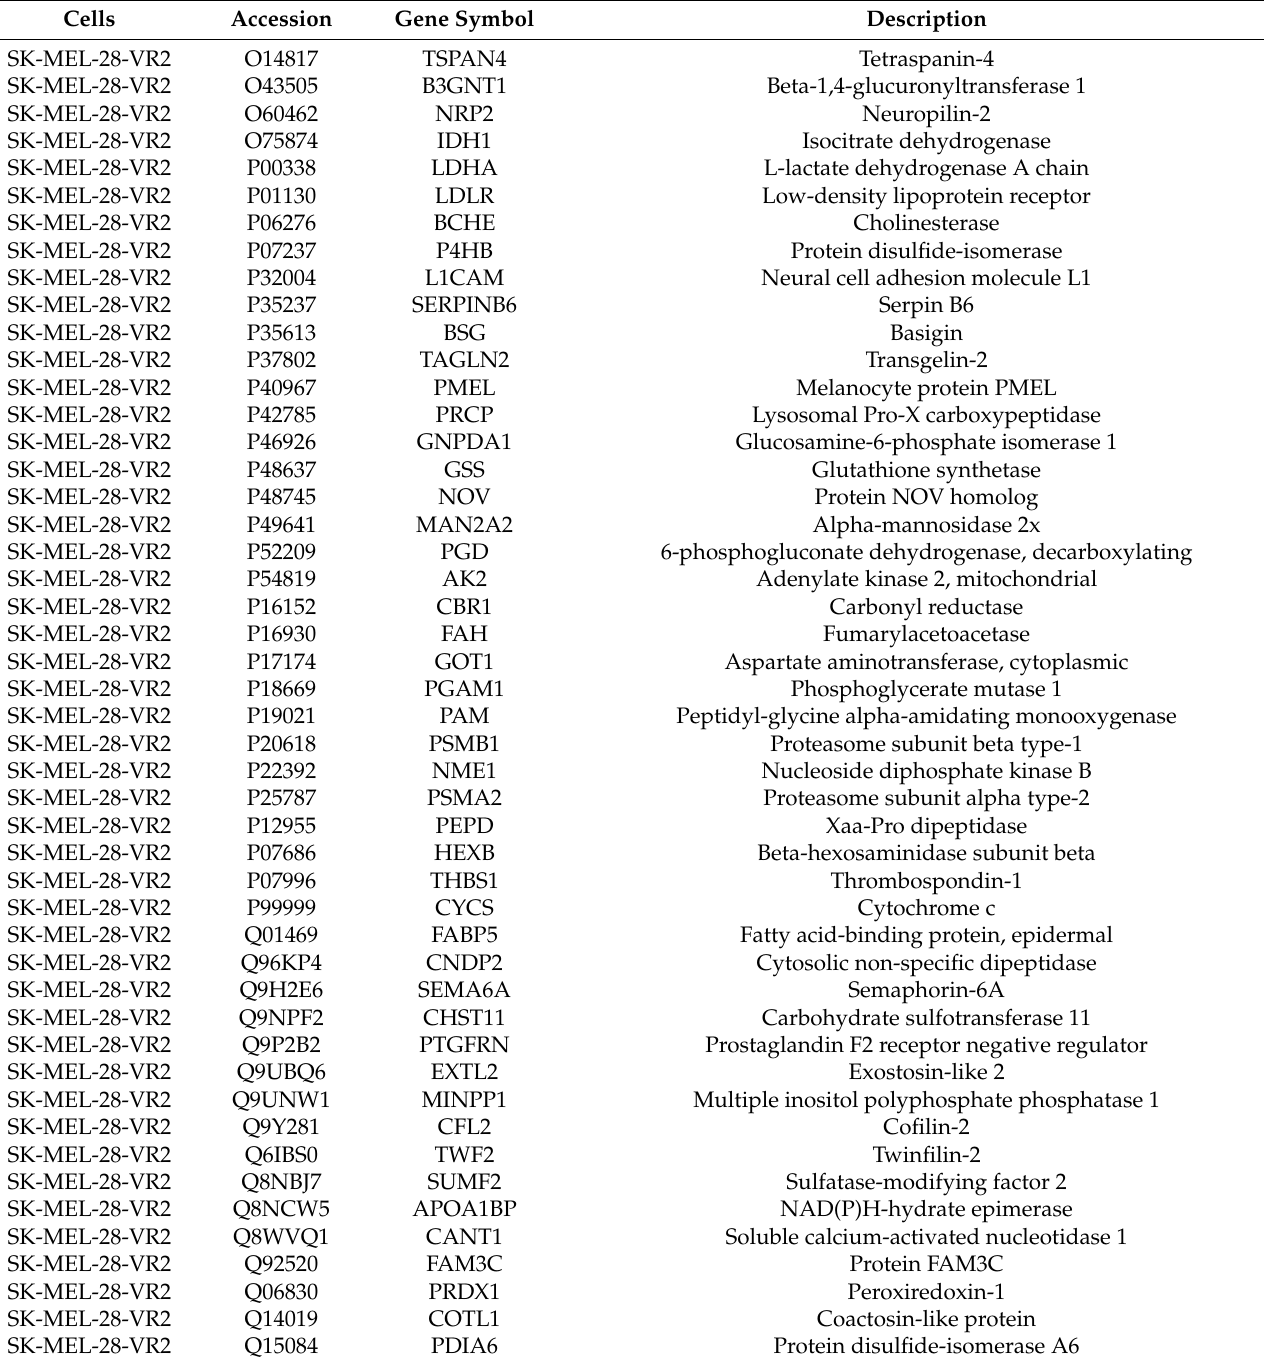
the GOnet tool. This analysis (molecular function; p ≤ 0.0005) highlighted three clear functional clusters related to cell adhesion (higher significance), catalytic activity, and isomerase activity (Figure